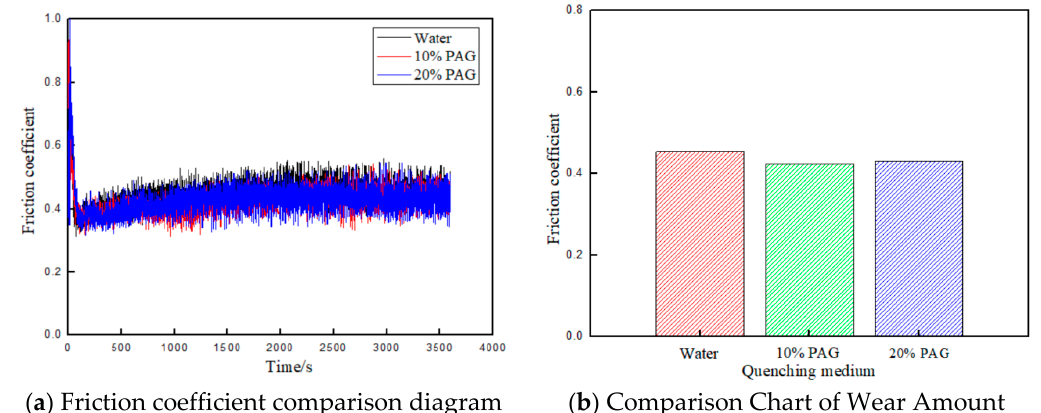
Figure 5. Relationship between friction coefficient and time of high chromium cast iron with different quenching mediums.